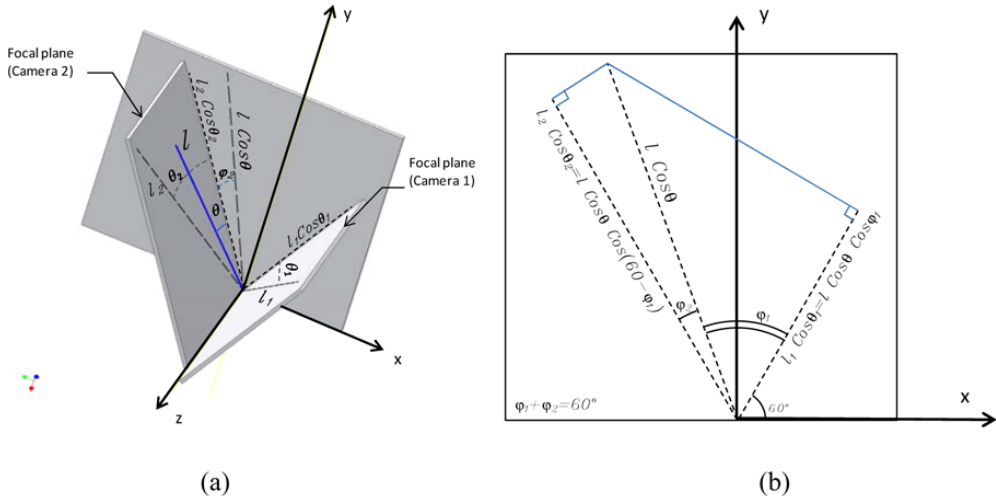
) between the particle area (A) the bounding 6 A